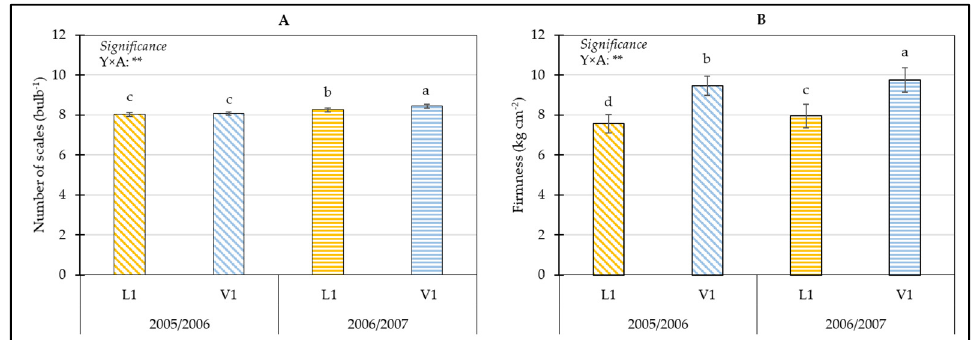
Figure 1. Influence of the interaction Y × A on the number of scales ( A ) and bulb firmness ( B ). Means with the same letter are not significantly different at p ≤ 0.05 according to Tukey’s test. Bars represent the standard error. ** = significant at p ≤ 0.01; Y = Year; A = Accession; L1 = Landrace (Bianca Calda di Comiso); V1 = Commercial Variety (Bianca di Maggio).